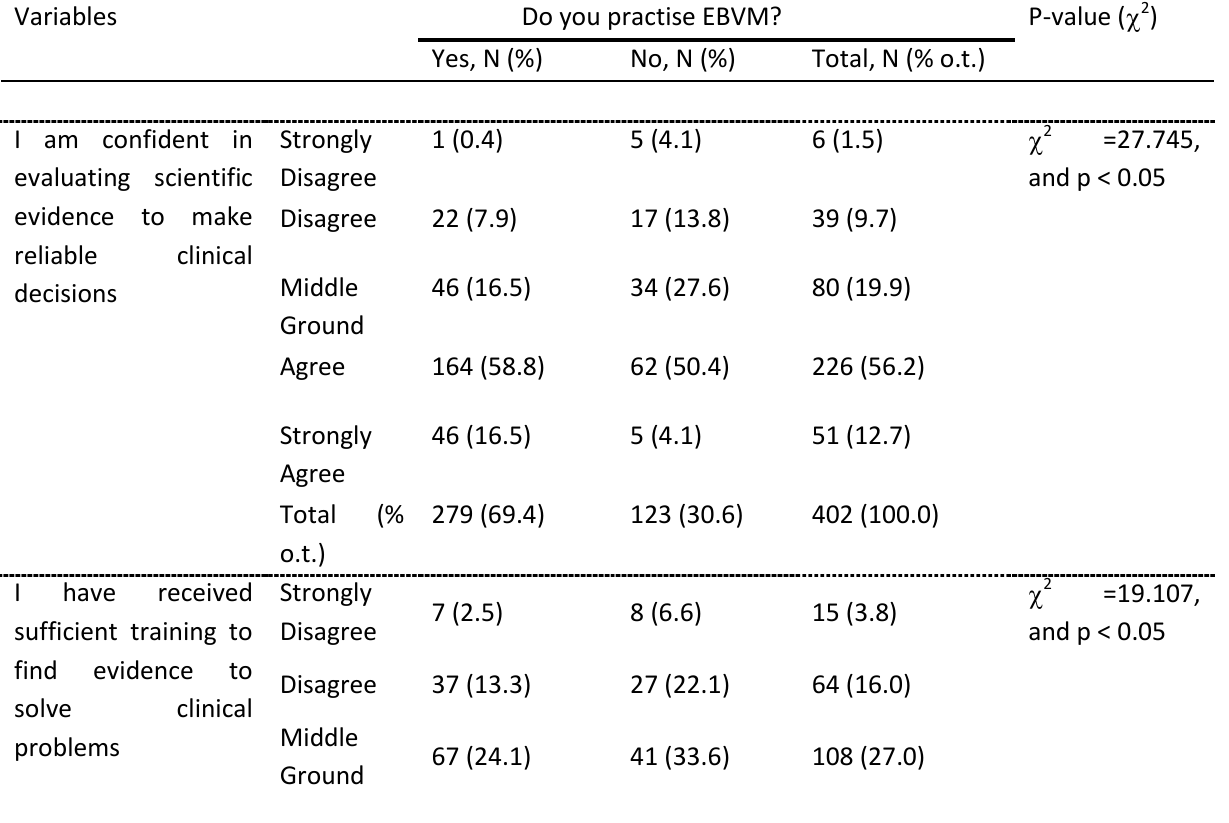
Table 11 : The ability to put EBVM into practice Variables Do you practise EBVM? P-value (  2 ) Yes, N (%) No, N (%) Total, N (%